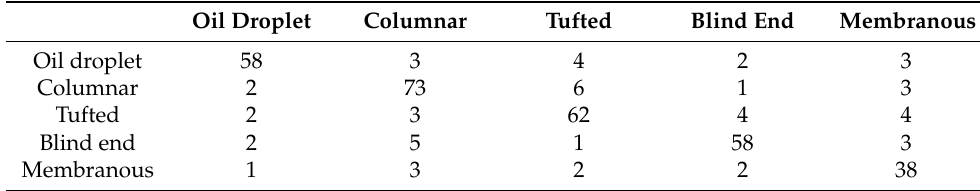
Table 1. Confusion matrix of the test result.